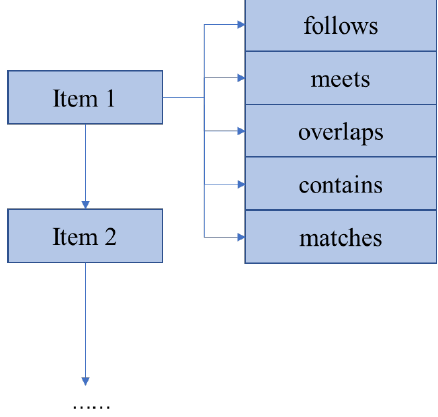
Figure 8. Head node of data structure diagram.